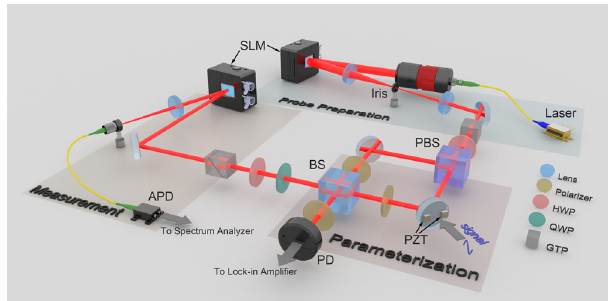
Fig. 5 | Diagram of experimental setup. The n -order HG beam is converted from an expanded Gaussian beam working at 780nm by an SLM and a spatial fi lter system. The pre-selection is implemented by a Glan-Taylor Polarizer and a HWP. And a polarized MZI is employed to implement the weak interaction procedure, where the incompatible parameters (position displacement and momentum kick) are introduced by a PZT-driven mirror. Then a quarter wave plate (QWP), a HWP, andanotherGlan-TaylorPolarizerareusedtoimplementthepost-selection.Finally, another SLM with a Fourier transfer lens is used to implement the non-orthogonal projection measurement, where the successfully projected photons are collected by an APD with an